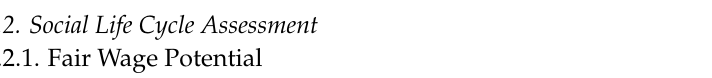
Figure 4. Normalized damage from ceramic masonry and concrete masonry.